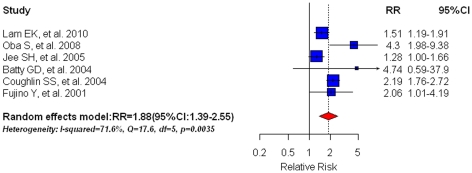
Summary estimate of relative risk (RR) for HCC specific mortality in diabetic patients compared with their non-diabetic counterparts.Squares represent study-specific estimates (size of the square reflects the study-specific statistical weight, i.e. inverse of the variance); horizontal lines represent 95% CIs; diamonds represent summary estimates with corresponding 95% CIs.